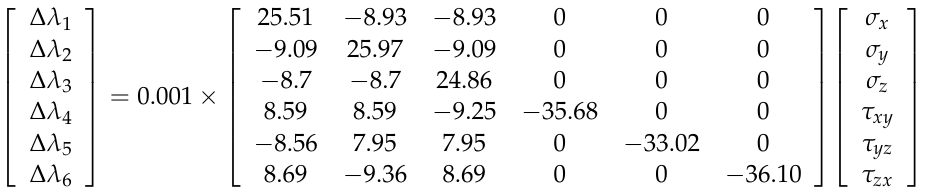
Figure 11. Calibration and test system of the sensor. ( a ) System schematic diagram; ( b ) Physical picture of